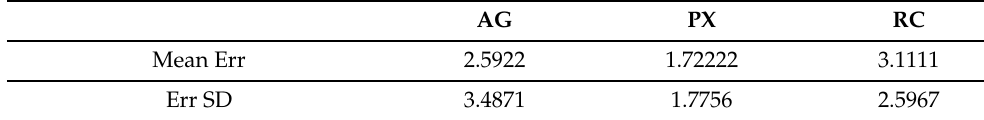
Table 4. Average err and its standard deviation using Agisoft (AG), Pix4d (PX), and RealityCatpure (RC) in